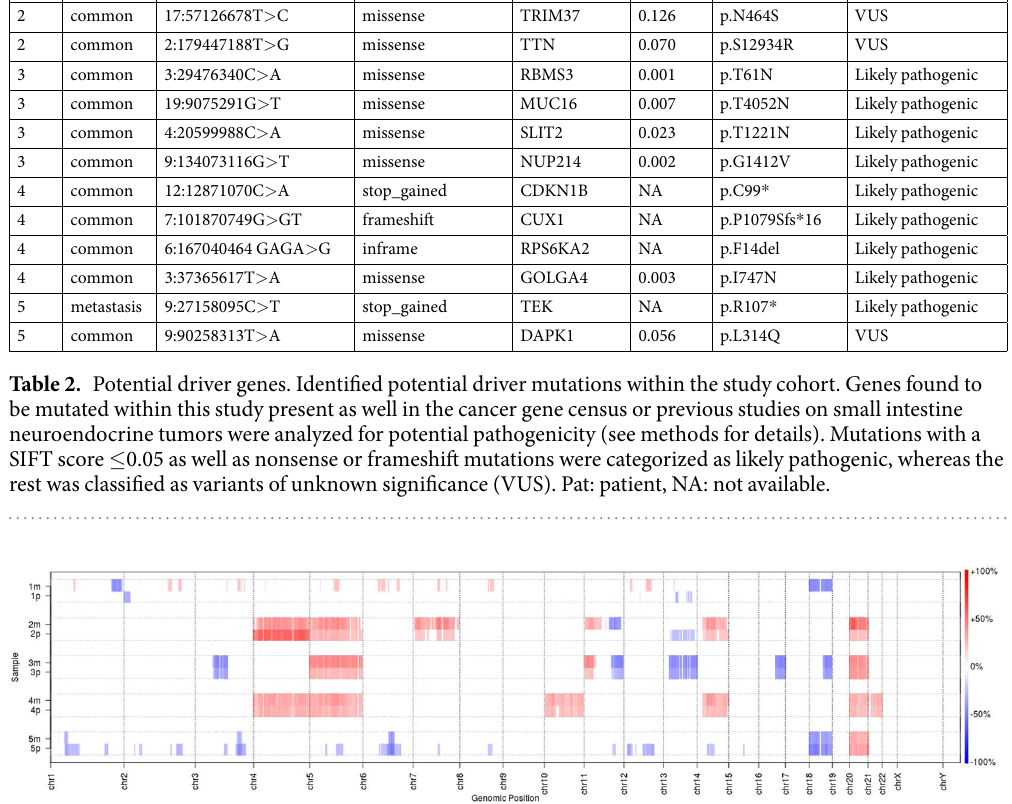
Figure 3. Copy number variations. Copy number variations of metastasis (m) and primary (p) of Patient 1–5. Copy number gains are shown in red, whereas losses are colored blue. Copy numbers of the control samples were subtracted and only copy number aberrations ≥ 20% were included (see methods for